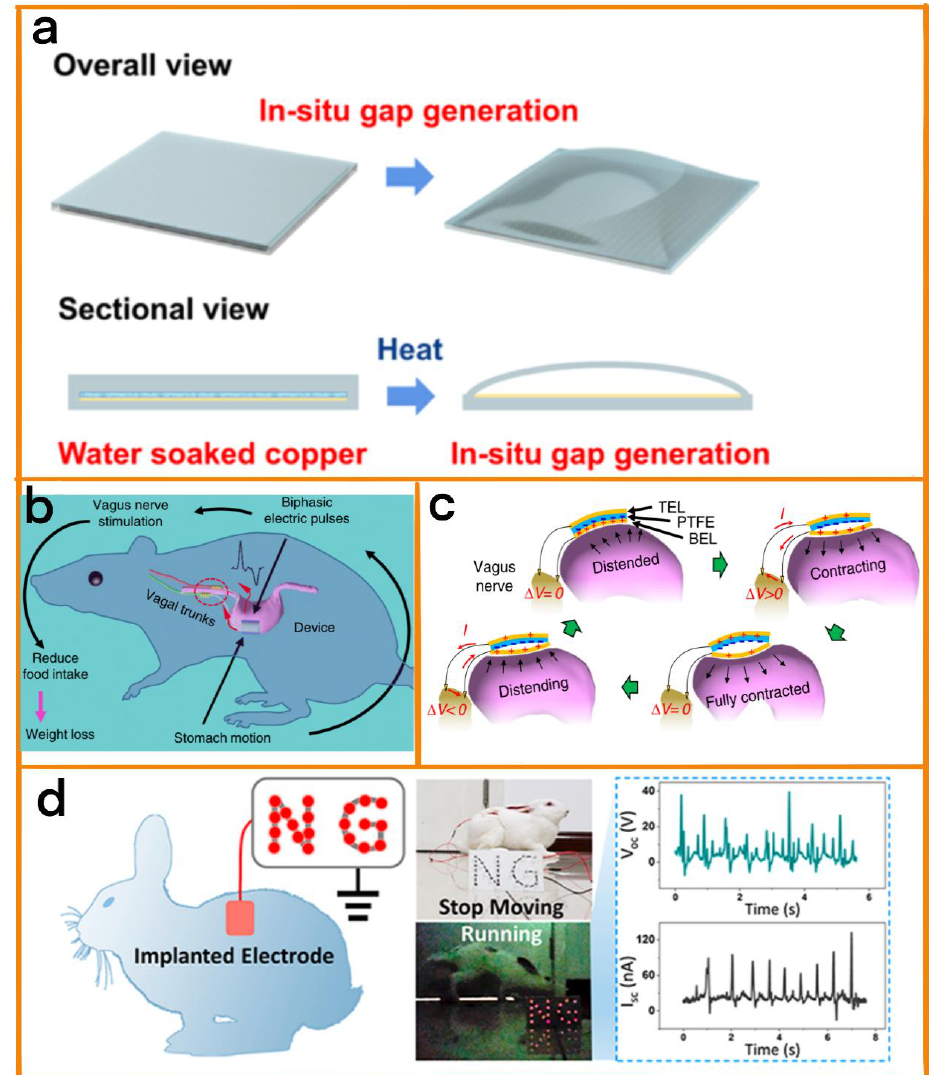
Figure 4. ( a ) Schematic diagram briefly showing the in situ air gap generation of NSTENG. Reprinted with permission from [49]. 2021, Elsevier. ( b ) Working principle of the relevant vagus nerve stimulation system, schematically showing the generation of two-phase electrical signals and the path of vagus nerve stimulation. ( c ) Schematic diagram of the power generation principle of the vagus nerve stimulation device at different gastric motility stages . Reprinted with permission from [50]. 2018, nature. ( d ) LED bulbs lit by BISS implanted in rabbits and the open circuit voltage and short circuit current of BISS during operation . Reprinted with permission from [52]. 2019, ACS.